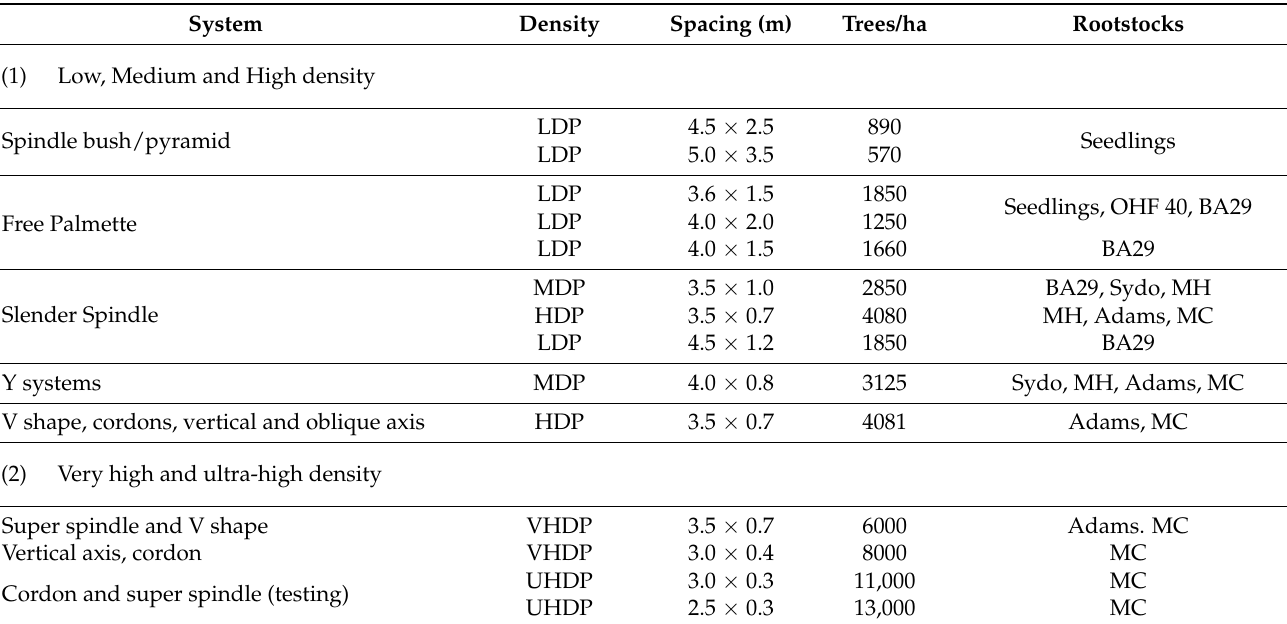
Table 2. Training systems, spacing, and rootstocks of pear orchards in Italy’s main district (2010–2020). System Density Spacing (m) Trees/ha Rootstocks